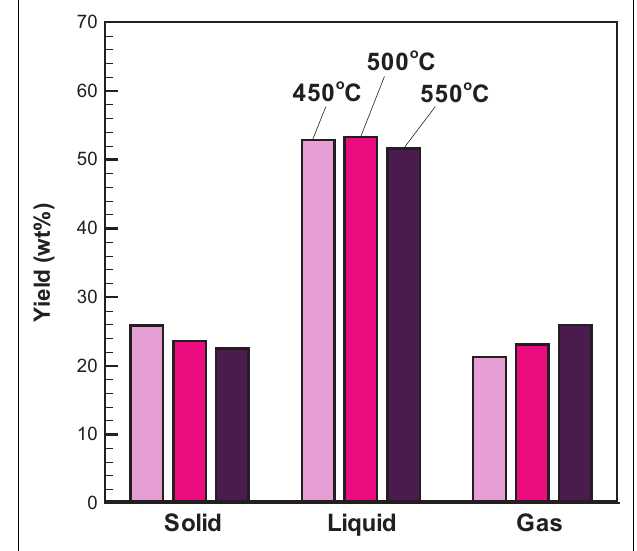
FIGURE 3 | Profiles of product yields from bagasse pyrolysis under conventional heating .